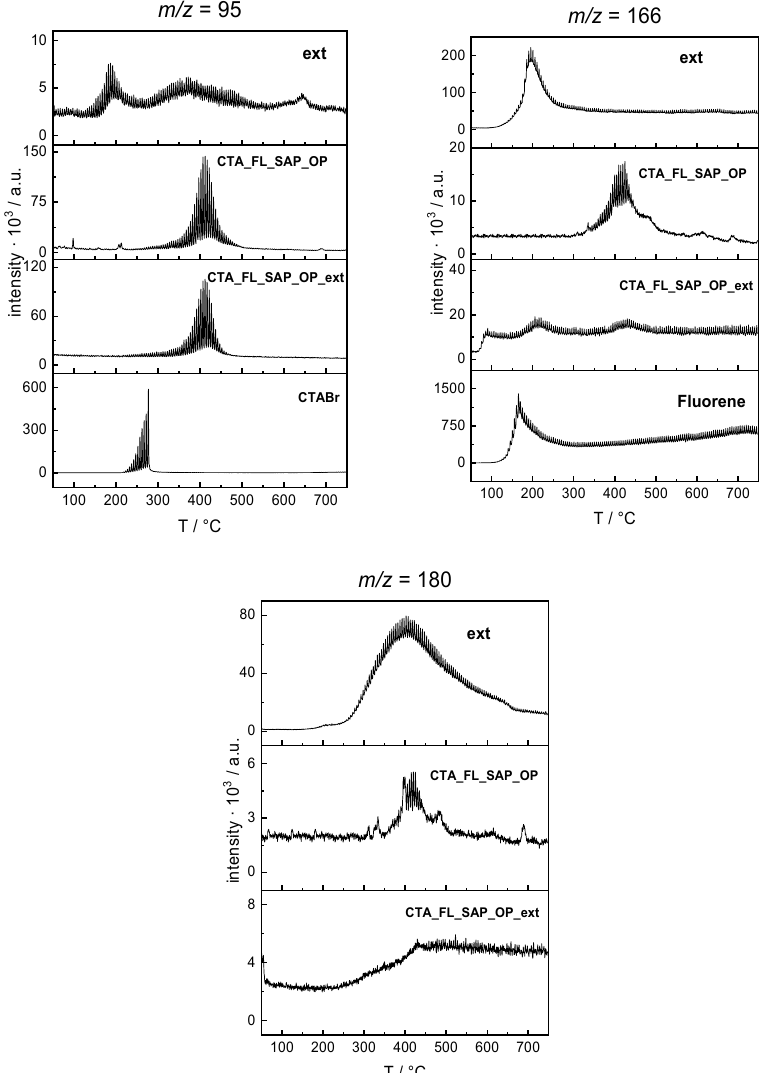
Figure 8. Evolution profiles of the signal at 95 m / z (CTABr) 166 m / z (Fluorene) and 180 m / z (fluorenone) recorded in the analyses of the pure samples (CTABr, Fluorene) and of the OP materials before and after the extraction together with the profile of the extract.